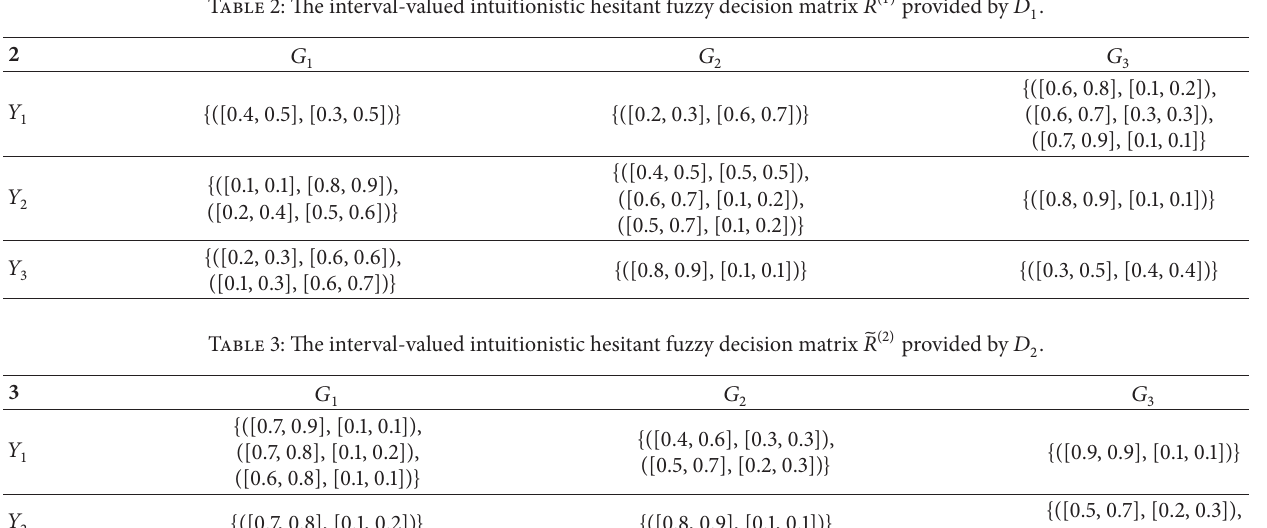
Table 2: The interval-valued intuitionistic hesitant fuzzy decision matrix